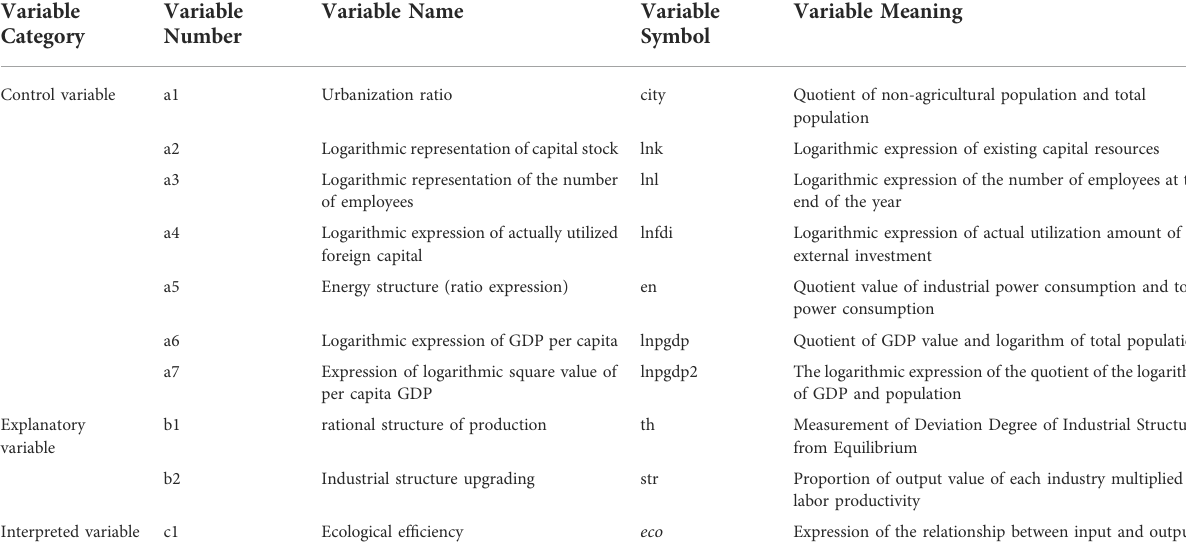
TABLE 1 Model index